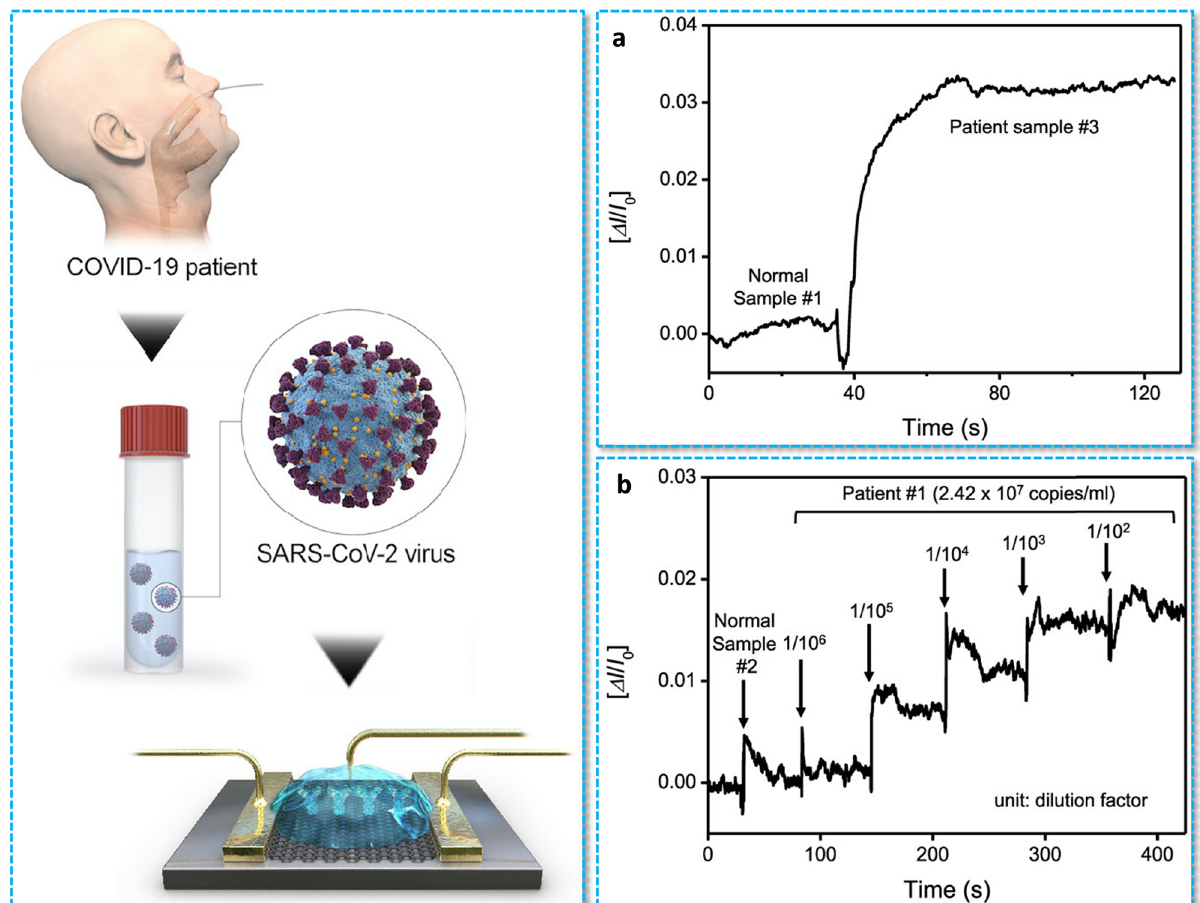
Figure 5: ( a ) Signals from the sensor the samples and ( b ) real - time response of sensor [ 75 ]